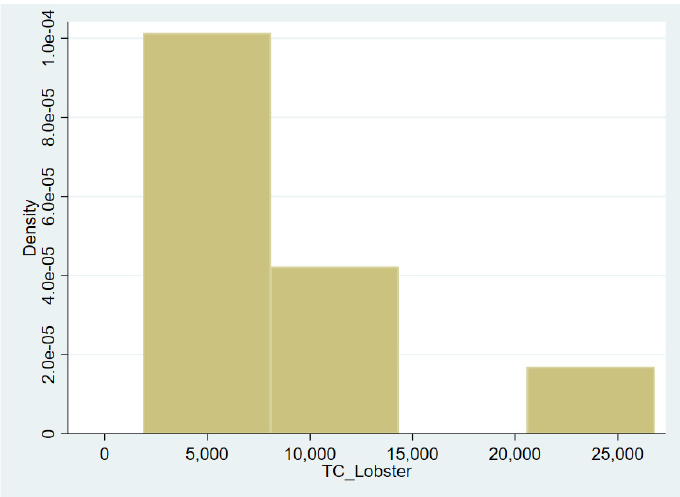
Figure 5. An illustration of profit differentials for lobster .